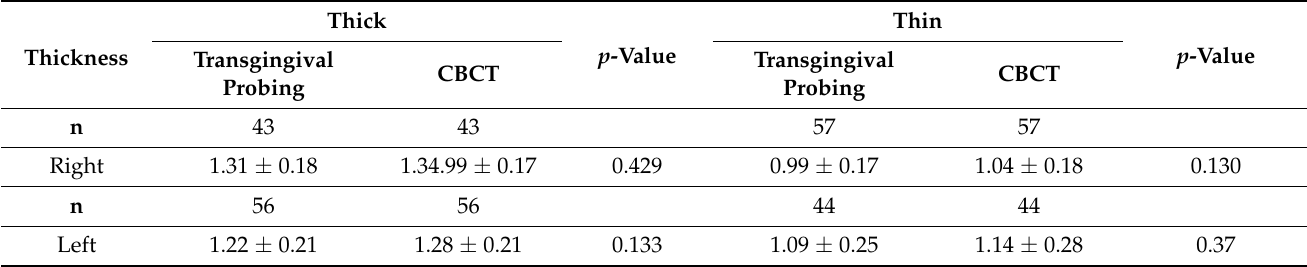
Figure 3. Soft tissue thickness, as measured by two methods, displayed according to the right and left sides. Table 1. Comparison between methods of mean gingival biotype thickness, according to the thick and thin categories and measured on the right and left sides.